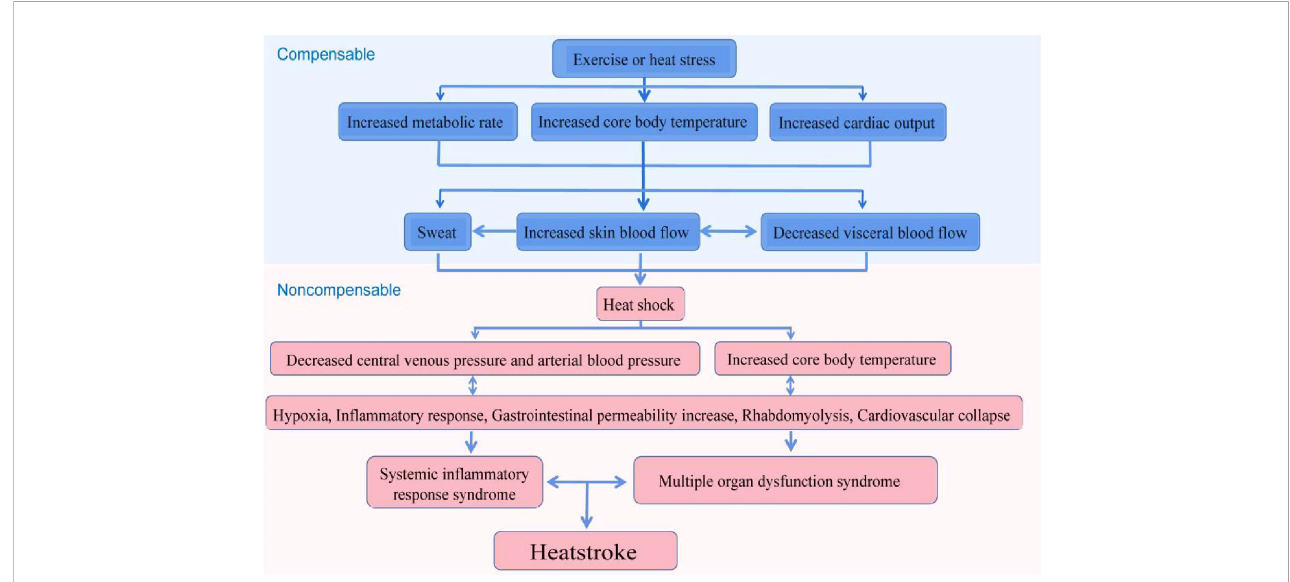
FIGURE 3 Possible pathophysiological pathway leading to heatstroke. The sequence of events leading to heatstroke involves a transition from a compensable thermoregulatory state to the non-compensable condition. Heat stress initiates a thermoregulatory response to maintain the balance of heat production and heat dissipation. When the arterial blood pressure begins to decrease substantially, the core temperature begins to increase rapidly and becomes non-compensable. This thermoregulatory failure aggravates pathophysiological processes, including the in fl ammatory response and multi-organ dysfunction, and is ultimately expressed as heatstroke